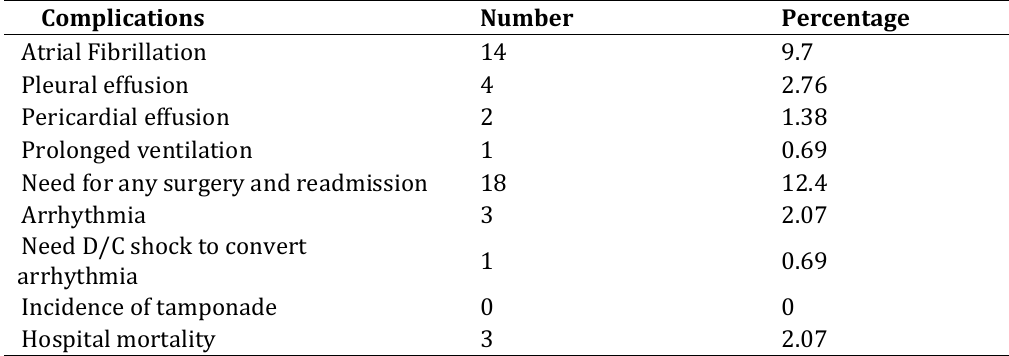
Table 5: Frequency distribution of postoperative complications